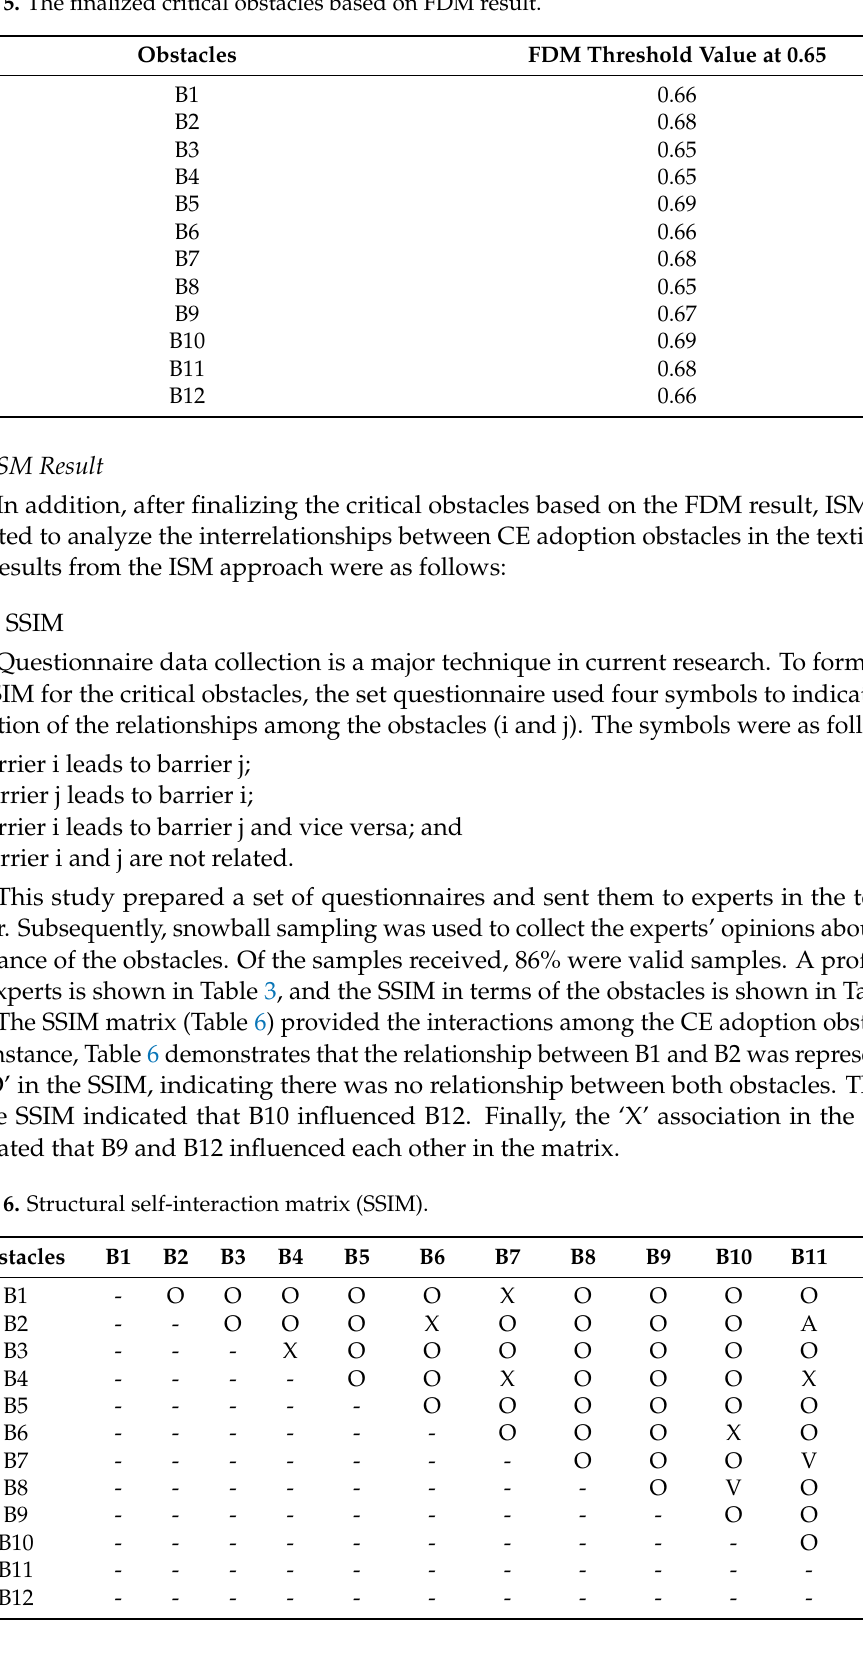
Table 5. The finalized critical obstacles based on FDM result.